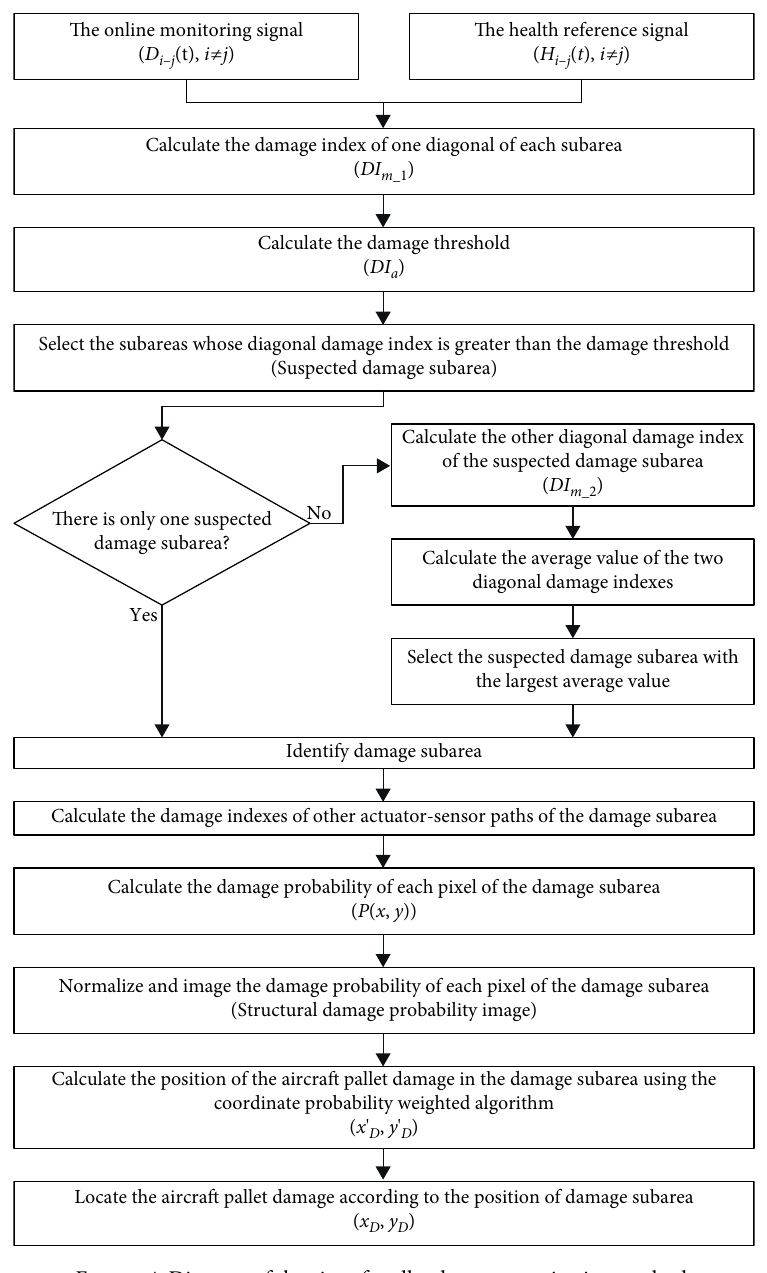
Figure 4: Diagram of the aircraft pallet damage monitoring